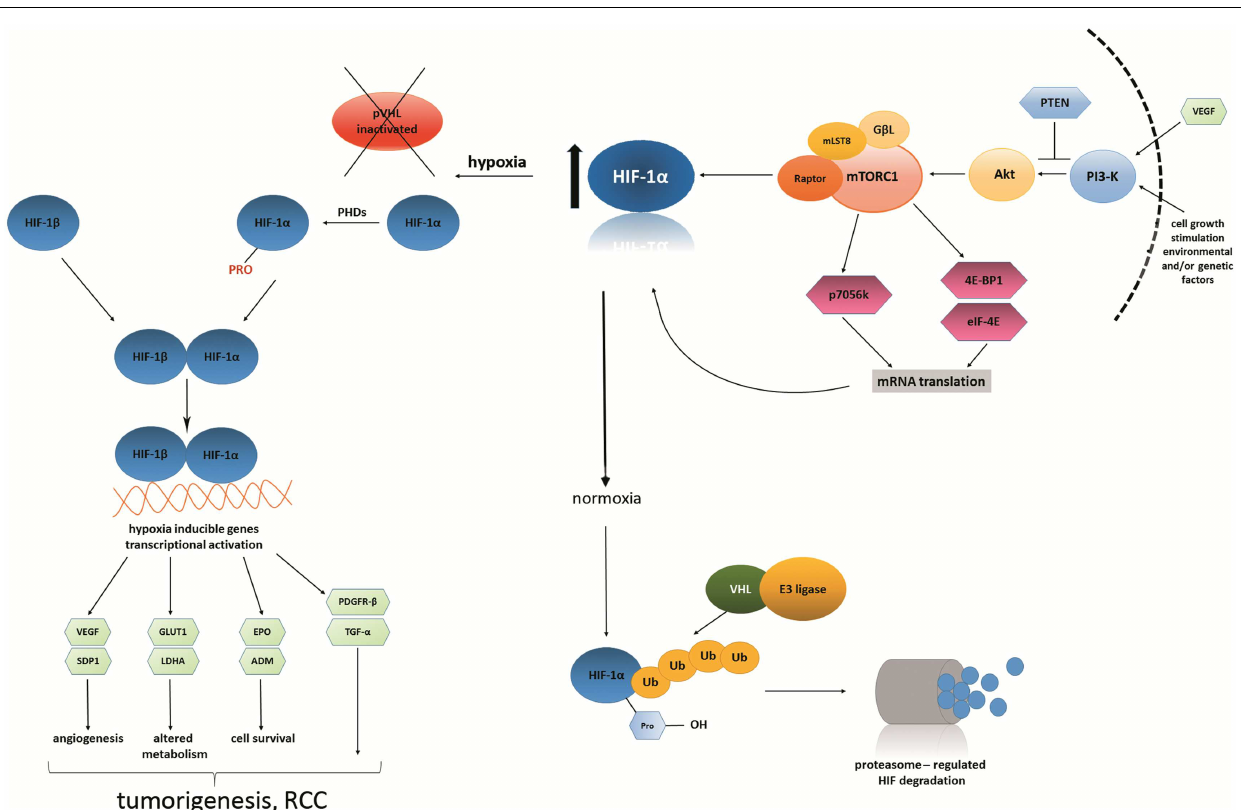
not degraded in such conditions; therefore, it translocates to the nucleus. Inside the nucleus, it undergoes dimerization with HIF- β subunit to form transcriptionally active HIF . In consequence, HIF as a transcription factor starts to regulate many biological processes via hypoxia-inducible genes, such as: SDP1 (scan domain containing protein), GLUT1 (glucose-transporter 1), LDH (lactate dehydrogenase), EPO (erythropoietin), ADM (adrenomedullin), PDGFR- β (platelet-derived growth factor- β ), TGF- α (tumor growth factor- α ). Other genes activated by mTORC1 complex: p70S6 kinase , 4E-BP1 (4E-binding protein 1), eiF-4E (eukaryotic translation initiation factor 4E) (143–146). Under conditions of normal oxygen tension (normoxia), HIF- α subunit is hydroxylated by specific prolyl-hydroxylases and subsequently targeted for rapid proteasomal degradation.This is done by theVHL tumor suppressor protein, which is active at the time. In other words, HIF protein is degraded in proteasome when prolyl-hydroxylated α -subunits are targeted to the process of ubiquitination. It occurs by high-affinity binding to theVHL E3 ubiquitin ligase.Tumorigenic processes do not occur (147,